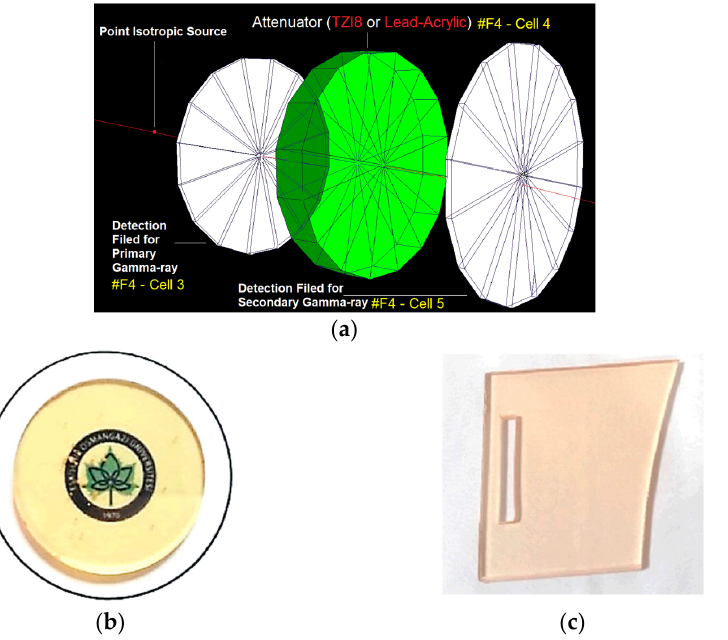
Figure 5. ( a ) Modelled MCNPX setup for transmission factor (TF) calculations; ( b ) physical appear ‐ ance of TZI8 glass sample [24]; ( c ) physical appearance of lead ‐ acrylic screen used by Koo and Lee pearance of TZI8 glass sample [24]; ( c ) physical appearance of lead-acrylic screen used by Koo and [17]. Lee